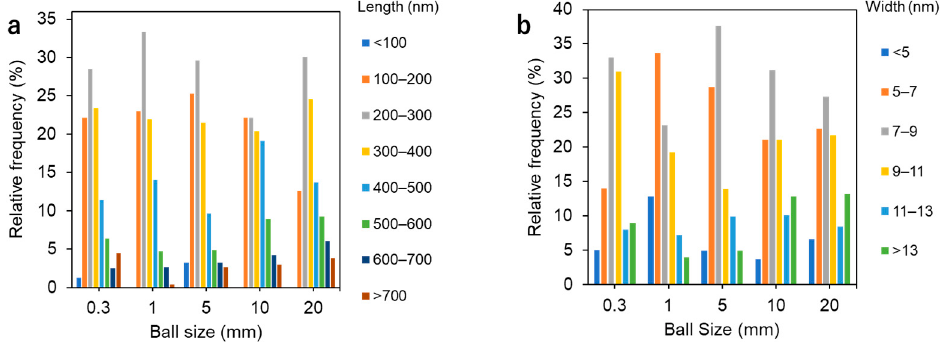
Figure 3. Distribution of ( a ) length and ( b ) width of chitin nanofibers milled at different ball